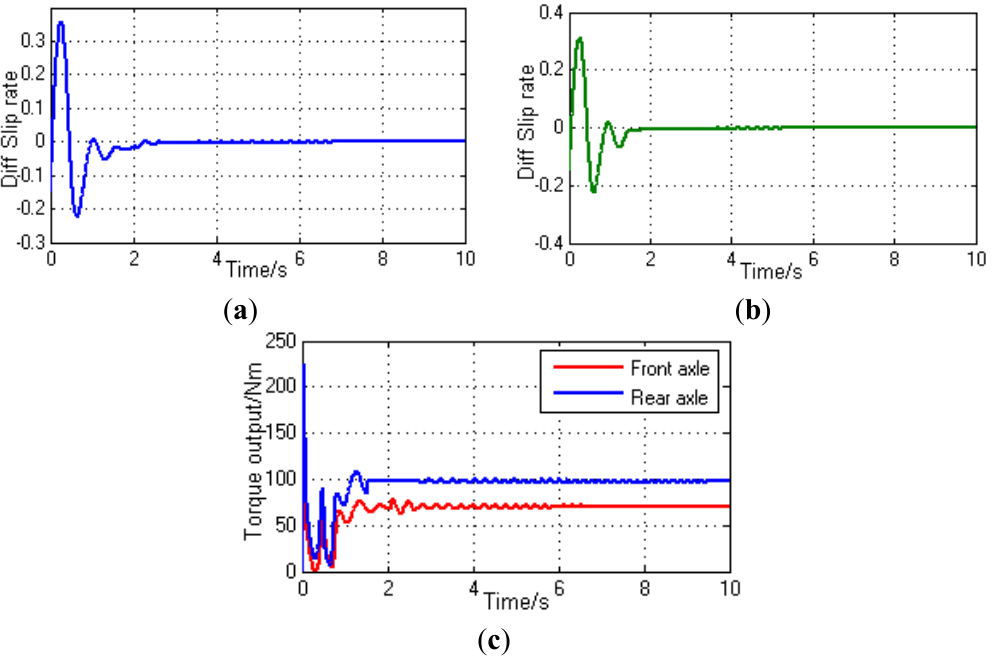
Figure 10. Front and rear axle input torque under different control modes: ( a ) Front axle slip rate control deviation; ( b ) Rear axle slip rate control deviation; ( c ) Output torque under independent control of the optimal slip rate